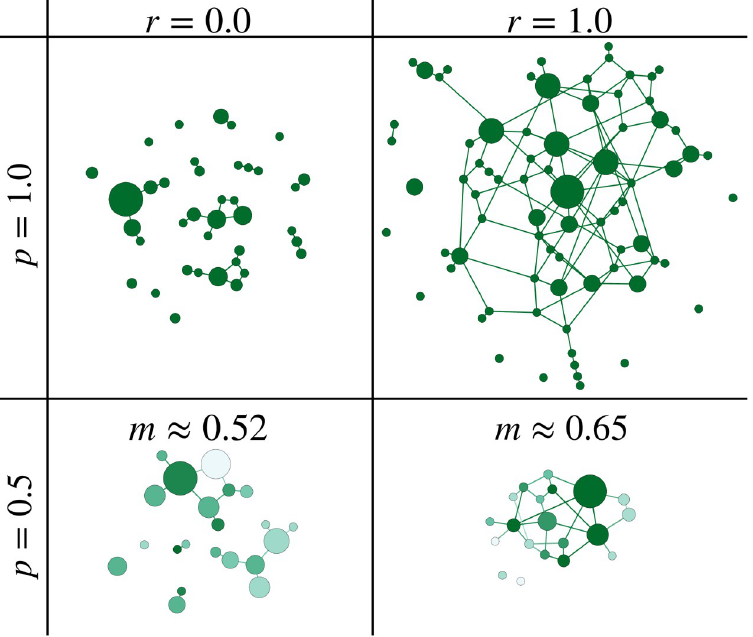
Fig 13. Graph representation of genotype clouds in the fsm with N = 100, L = 10, μ = 0.01. The population has evolved for 10 6 generations starting from a random viable genotype. Links connect genotypes that differ by a single mutation, and node sizes represent the frequency of the corresponding genotype in the population; see Illustration of results for details. The networks on the left show non-recombining populations ( r = 0) and on the right obligately recombining populations ( r = 1). In the top panels all genotypes are viable ( p = 1), whereas in the bottom panels half of the genotypes are lethal ( p = 0.5). In the bottom row the mutational robustness of genotypes is shown by color coding with dark green representing high robustness and pale green low robustness, and the average robustness m is also indicated. Node sizes are normalised such that the smallest and largest node of each panel are equal in size.